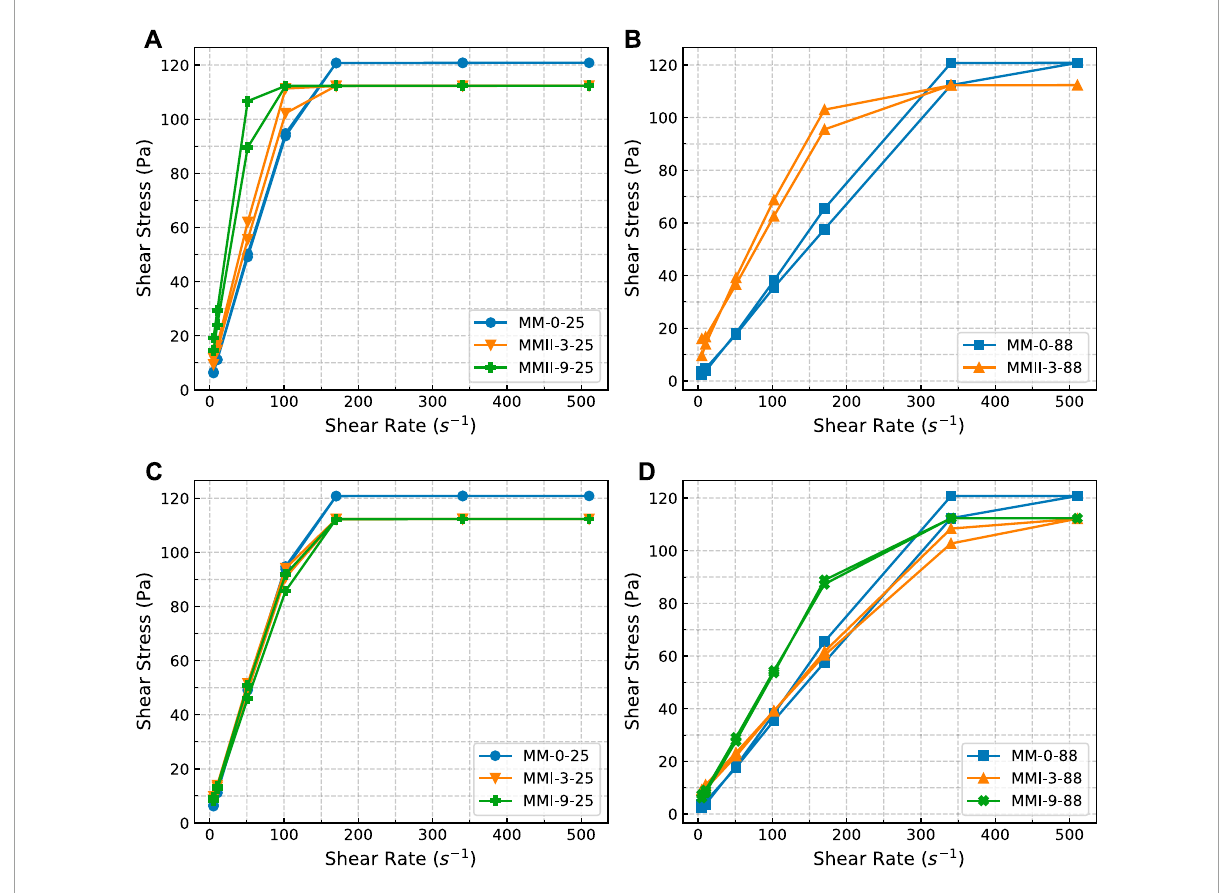
FIGURE 4 Hysteresis loops of slurry samples. (A) Slurry samples (base slurry and mixed with MMII, respectively) tested under 25 ° C; (B) slurry samples (base slurry and mixed with MMII, respectively) tested under 88 ° C; (C) slurry samples (base slurry and mixed with MMI, respectively) tested under 25 ° C; (D) slurry samples (base slurry and mixed with MMI, respectively) tested under 88 ° C; MMI refers to type I micro-sized magnesium oxide; MMII refers to type II micro-sized magnesium oxide; MM refers to micro-sized magnesium